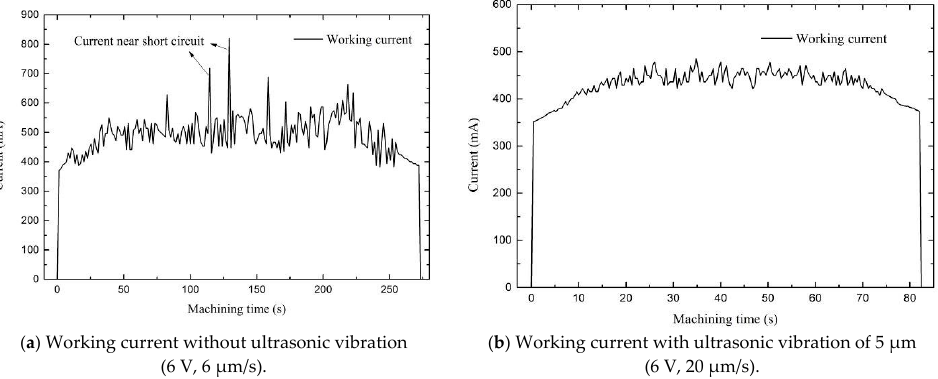
Figure 10. Current signals during machining process with and without ultrasonic vibration.